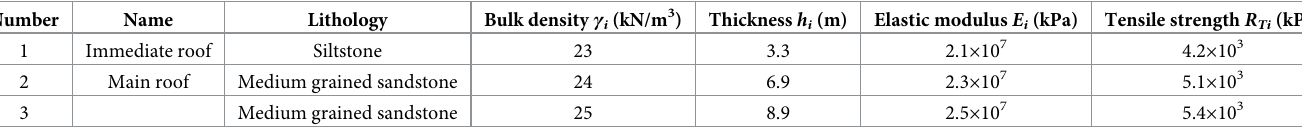
Table 2. Physical and mechanical parameters of roof strata above No.7 coal seam.